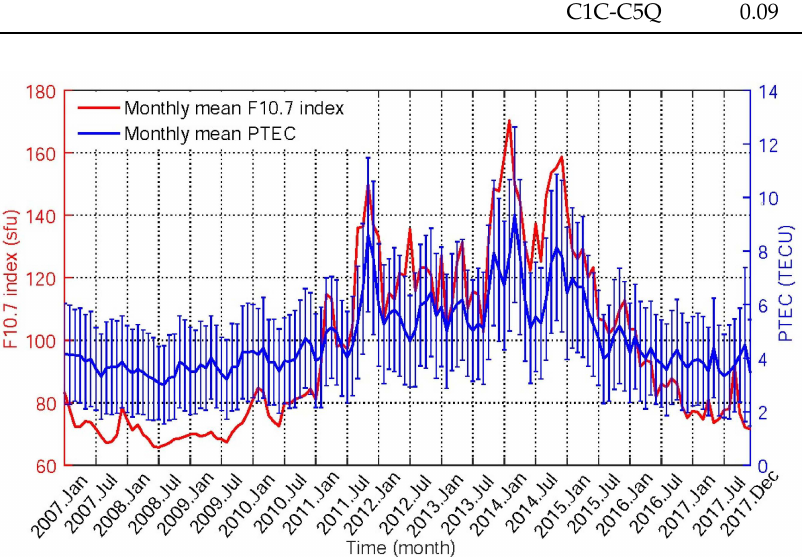
Figure 5. Monthly mean F10.7 index and monthly mean PTEC from January 2007 to December 2017